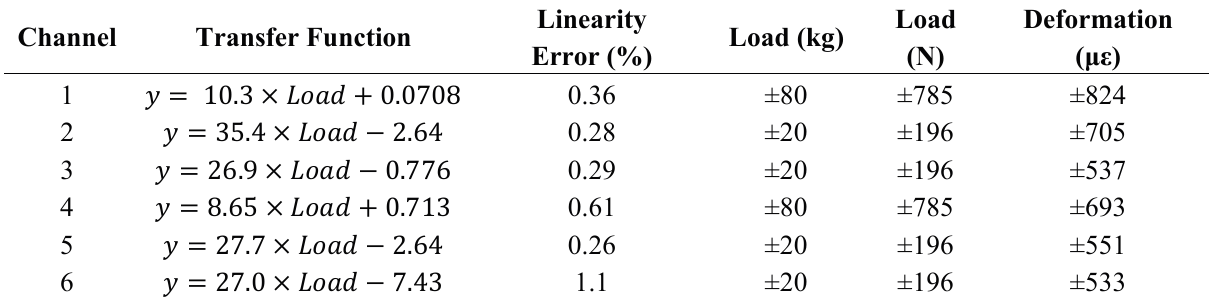
Table 1. Load cell characteristics for conditioning channels design.